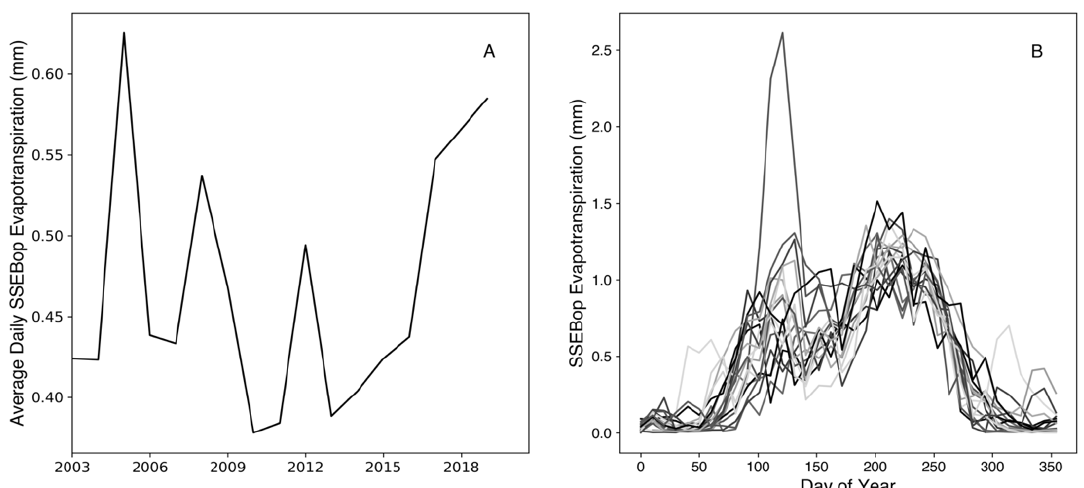
Figure 11. ( A ) Annual mean daily evapotranspiration from 2003 to 2020 ( B ) Daily SSEBop evapotranspiration on different date of year from 2003 to 2020, with darker lines representing more recent years.